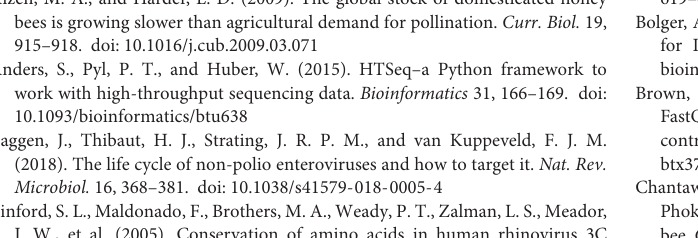
Supplementary Figure 4 | Immunoprecipitation of native and denatured VP1 by anti-VP1 (524-750) antibody. Native and heat-denatured lysates prepared with DWV-infected pupa were immunoprecipitated by anti-VP1 (524-750) antibody. The eluted immunoprecipitates with different volume (5, 10, 15, and 20 µ L) were analyzed by western blot using the same antibody. White and black arrow heads represent IgG heavy chain and VP1, respectively. VP1 is only